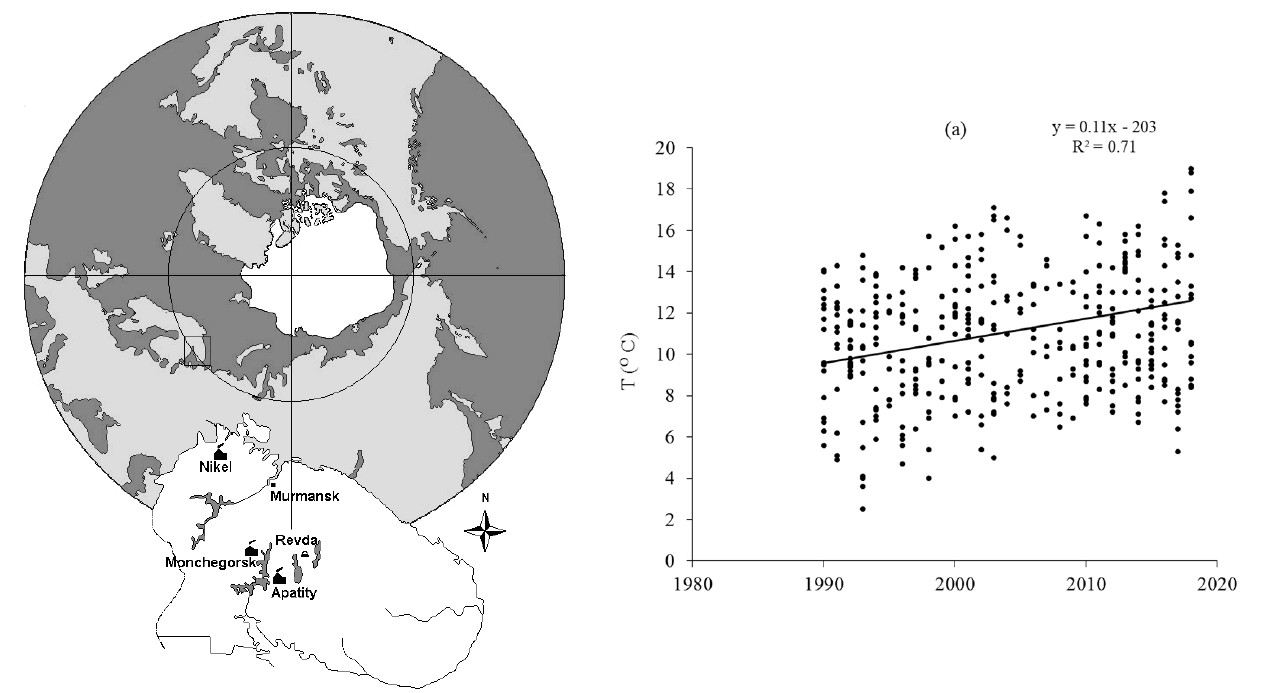
Figure 3. An example of an increase in mean monthly surface air temperature T (C) a 28 year period (1990–2018) on the territory of the Kola North. Significant positive slope of the temperature (T) SKT = (+4.71), p < 0.001.